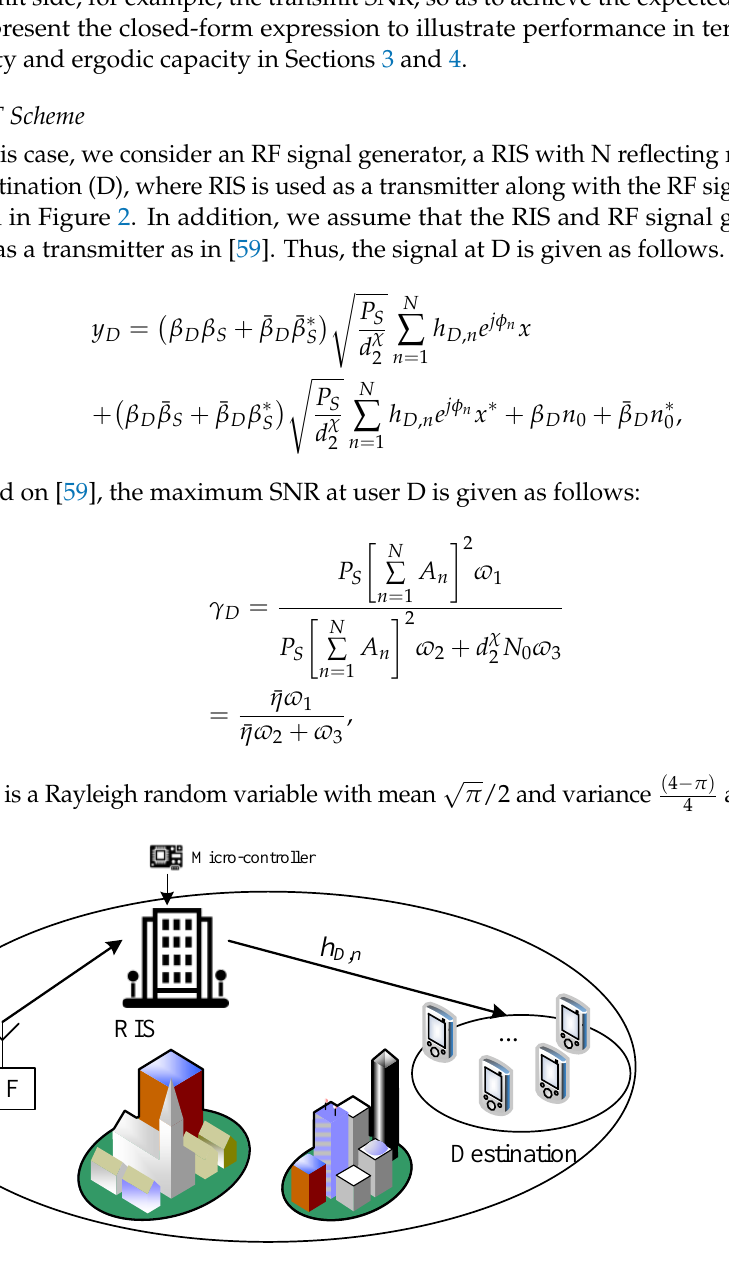
Figure 2. System model for RIS acting as a